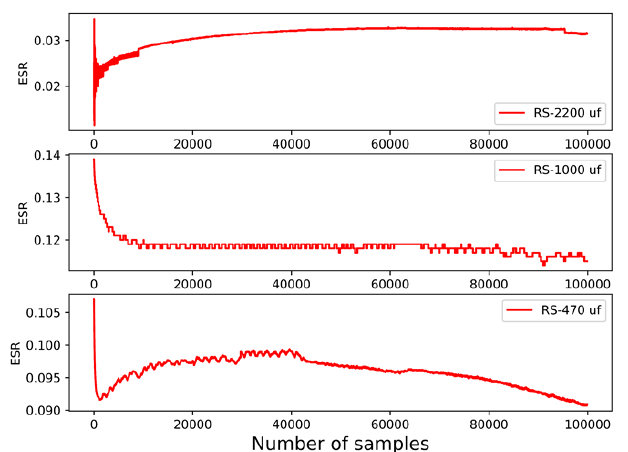
Figure 10. Exploratory time series data analysis of the equivalent series resistance (ESR) across the three